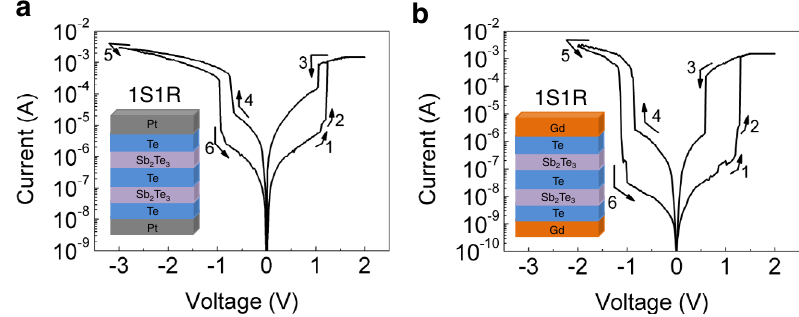
Fig. 4 1S1R characteristics in a tandem of two identical TST devices. I – V curves of the ( a ) PTSTSTP device and ( b )